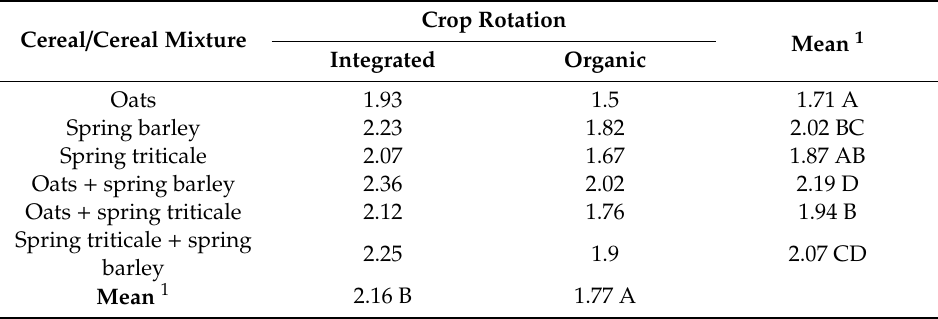
Table 6. Leaf area index (m 2 m − 2 ) of cereals in pure sowings or in mixtures in integrated or organic crop rotations, means for the years 2011–2019.